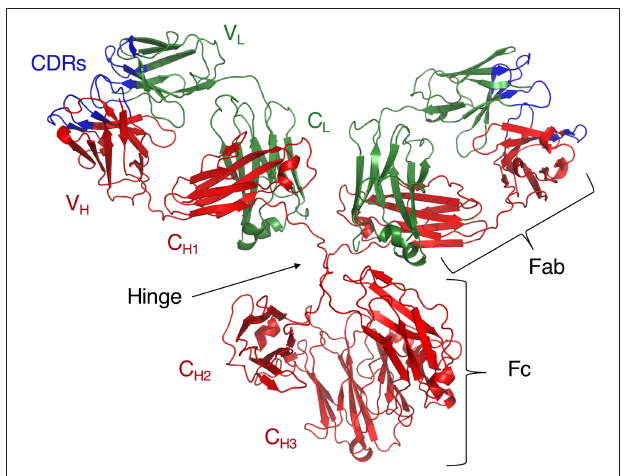
FIGURE 1 | Crystal structure of intact IgG 1 (PDB ID: 1IGY). Adapted from Harris et al.